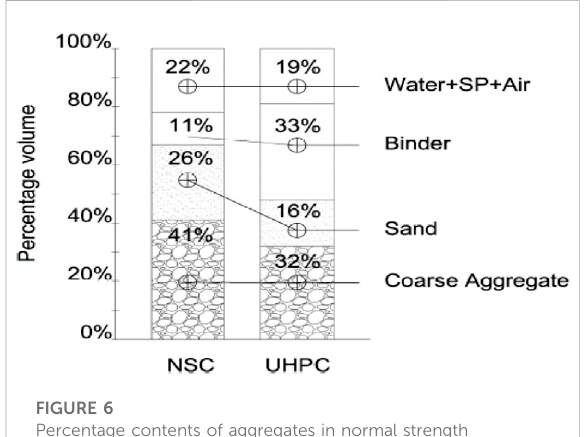
FIGURE 6 Percentage contents of aggregates in normal strength concrete (NSC) and UHPC (Sidodikromo et al., 2019).